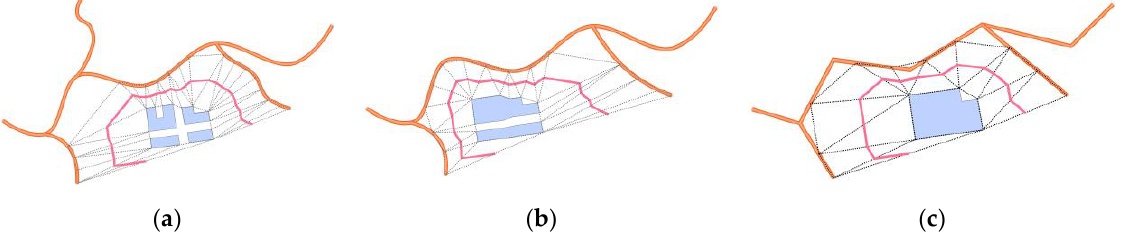
Figure 11. Construction of direction Voronoi diagram: ( a – c ) the directional Voronoi diagrams con- structed using the three scales of micro scenes.